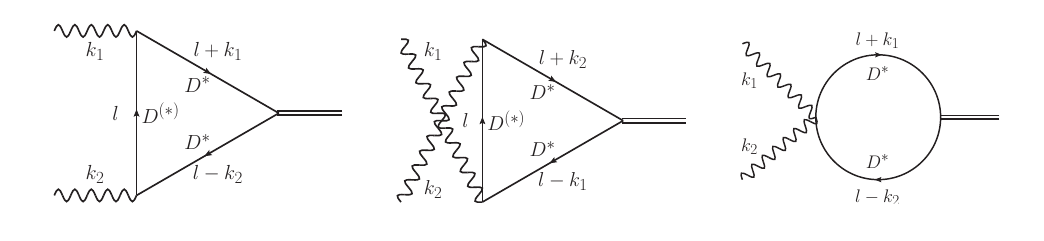
Figure 1. Diagrams contributing to amplitude (1) in the molecule picture of the X